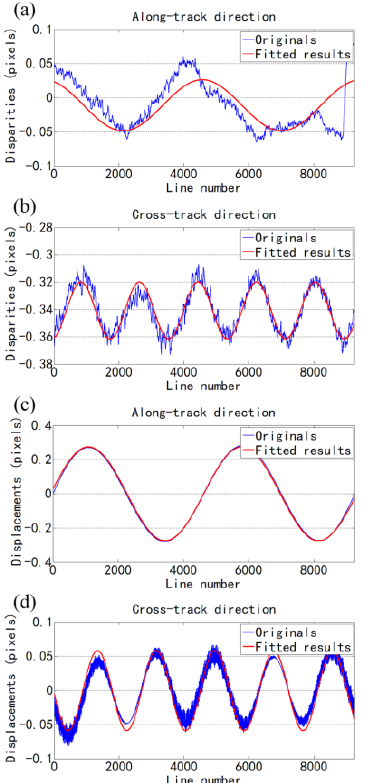
Figure 7. An example of scene Orbit 5619-7-130 illustrates the case of the estimated results. The mean parallax disparity obtained with Band2 and Band3 in (a) the along-track directionand (b) the cross-track direction. The image displacement caused by attitude perturbance in (c) the along- track directionand (d) the cross-track direction